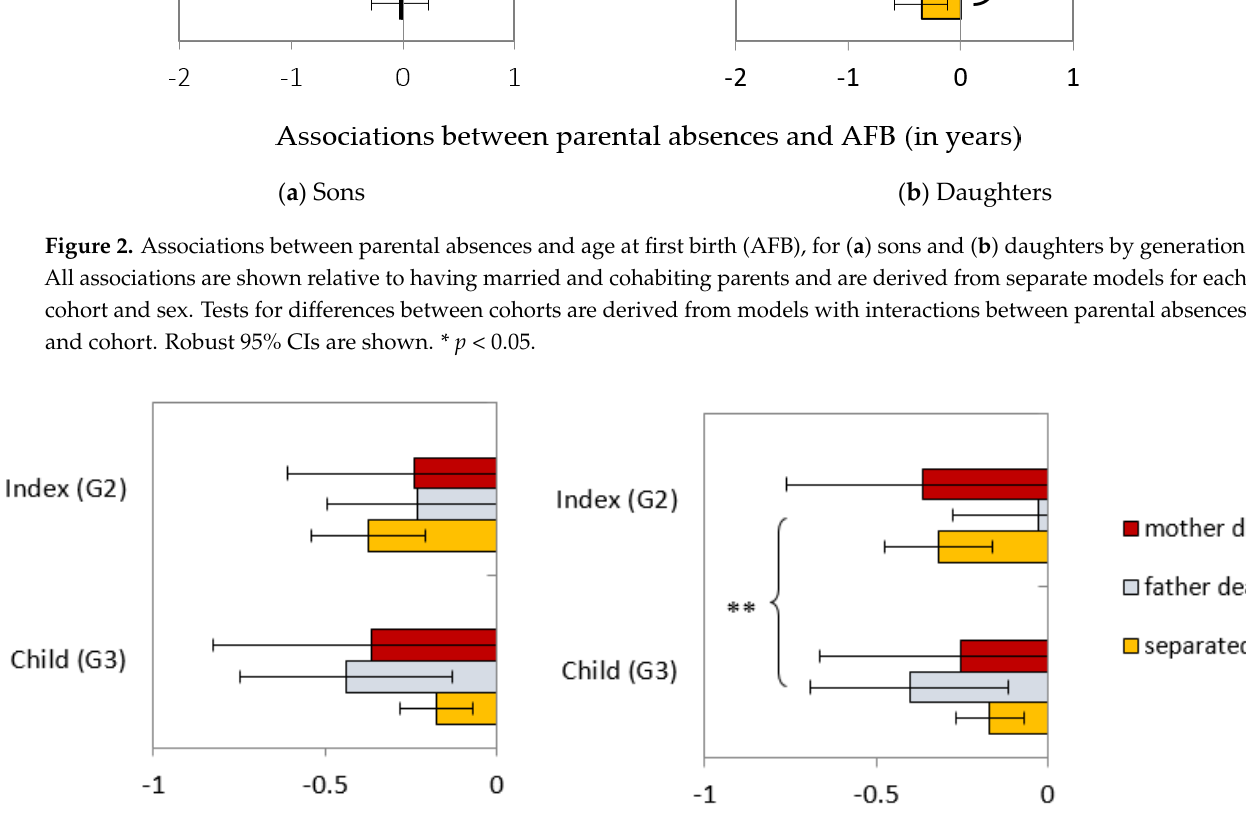
Figure 3. Associations between parental absences and university attendance for ( a ) sons and ( b ) daughters, by generation. All associations are shown relative to having married and cohabiting parents and are derived from separate models for each cohort and sex. Tests between cohorts are derived from models with interactions between parental absences and cohort. Robust 95% CIs are shown. ** p < 0.01.